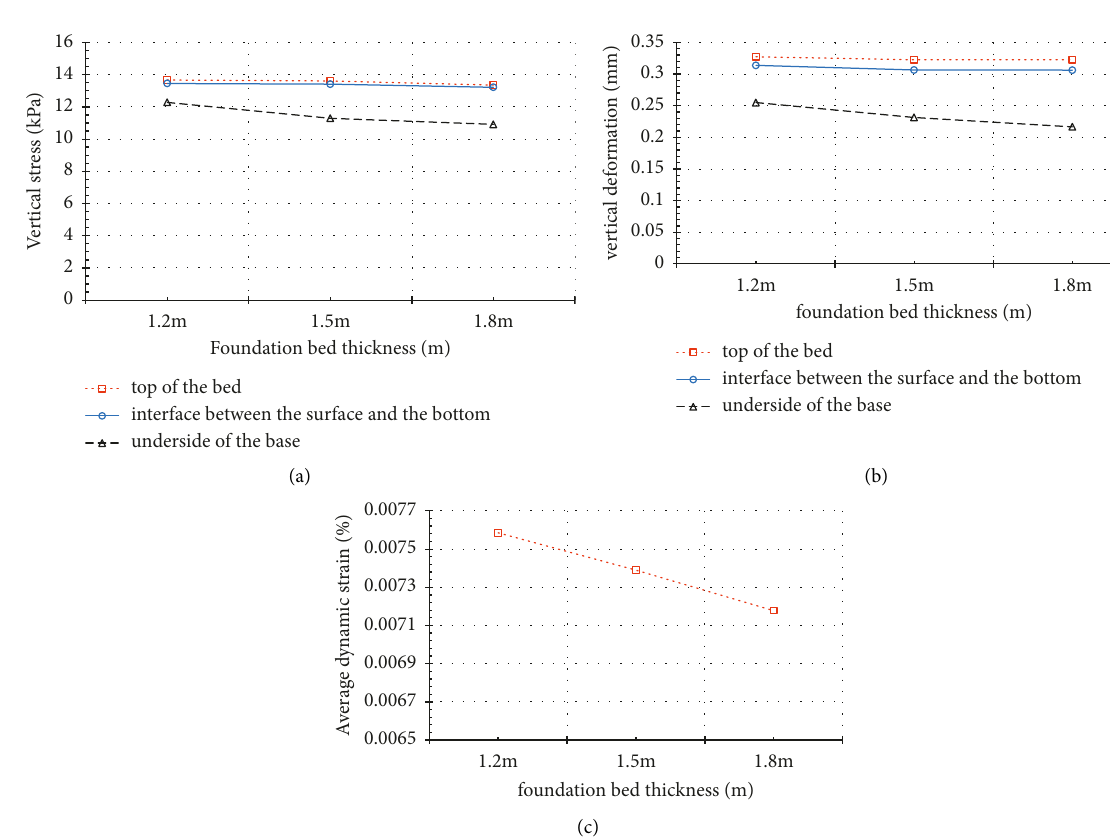
Figure 17: Strain distribution curve of the cross section of the foundation bed: (a) dynamic stress response; (b) deformation response; (c) dynamic strain response.